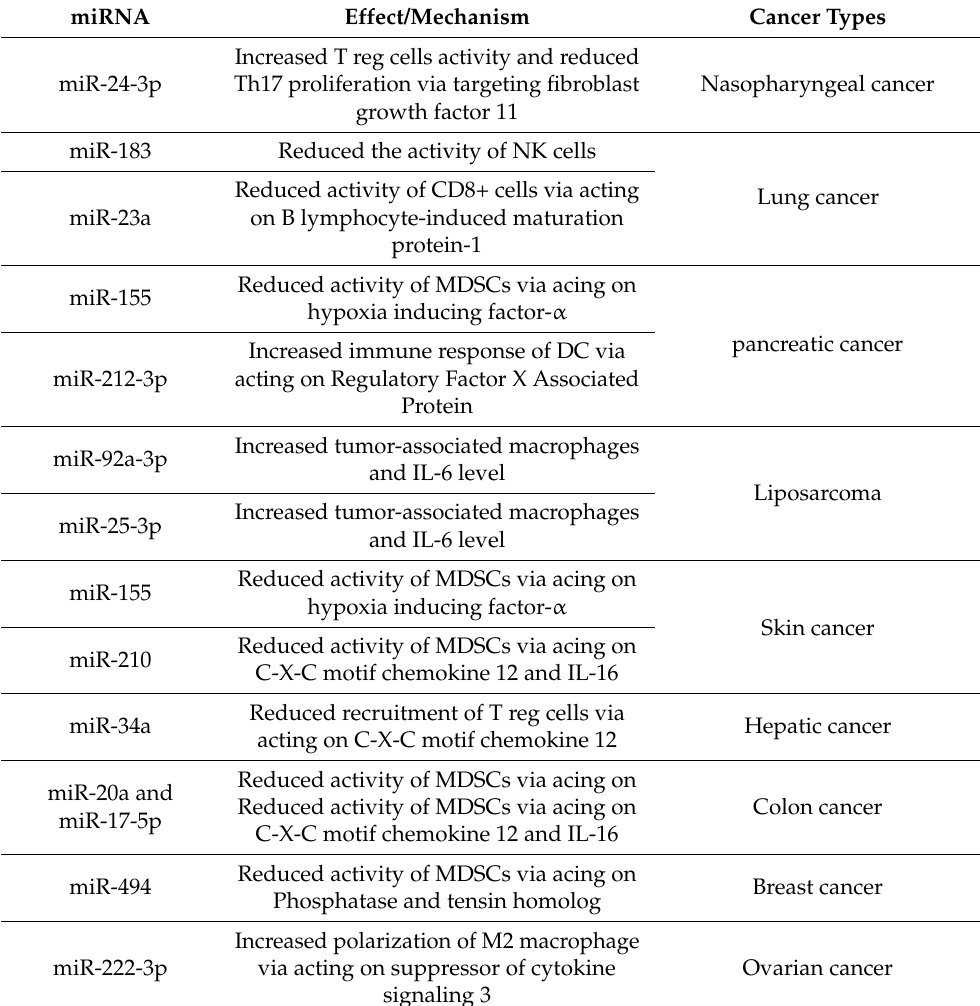
Table 3. Role of miRNAs in Cancer immune escape